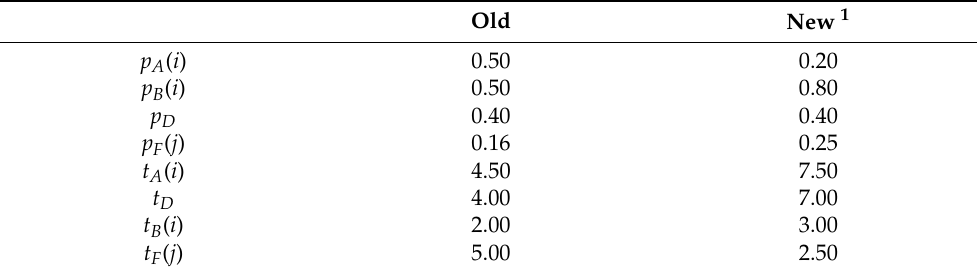
Table 1. Numerical Example of Transformed Parameters in The Standard Binary Tree for Ordered Processes.